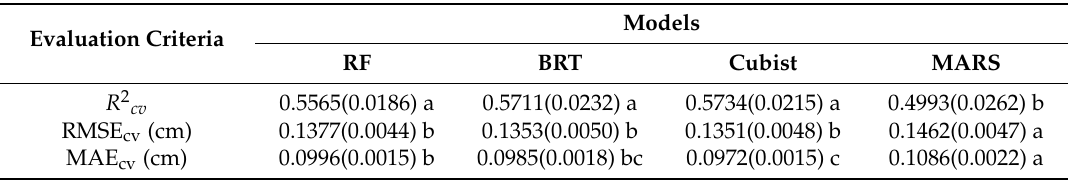
Table 3. The predictive performance measures of four optimal models based on tenfold cross- validation.